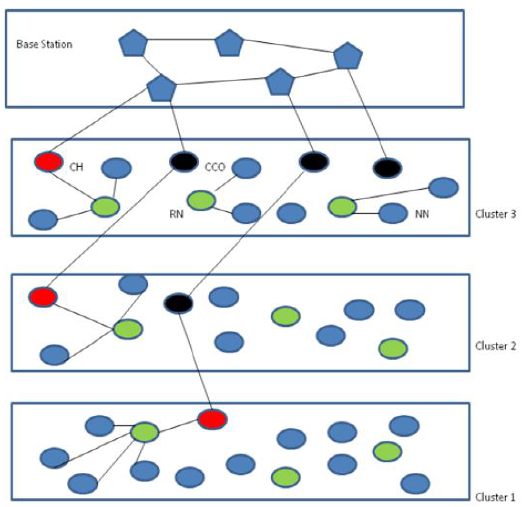
Figure 1. Multi-tier Framework for IoT (CH: Cluster Heads; CCO: Cluster Coordinators; RN: Relay Nodes; NN: Normal